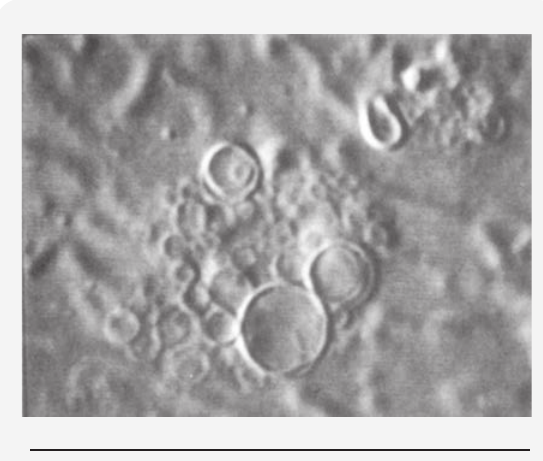
Figure 16. Reverse vesicles in decane. The vesicle membranes are assembled from molecules that contain hydrophobic regions that point out to the decane phase, and hydrophilic regions that cluster together in the middle of the membrane. Image from H Kunieda, K Nakamura, and DF Evans. Formation of Reversed Vesicles.